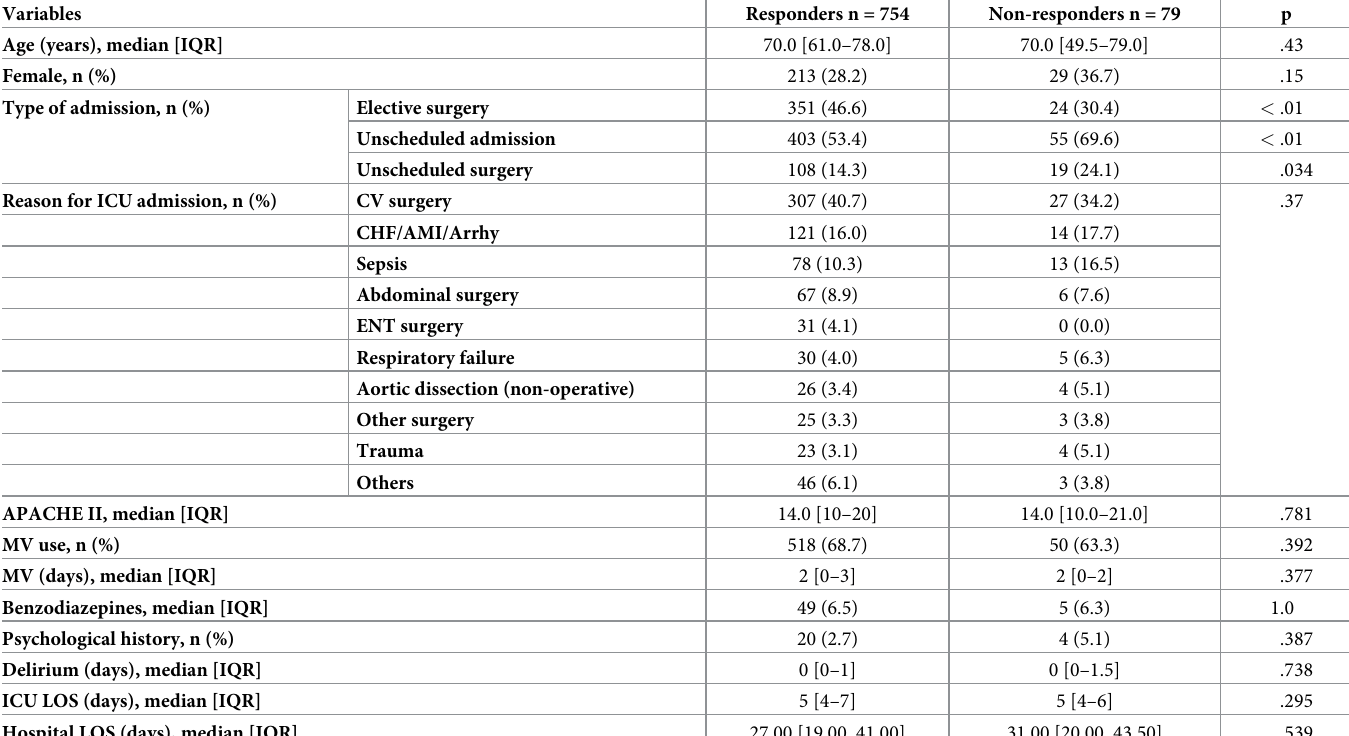
Table 1. Demographics of responders and